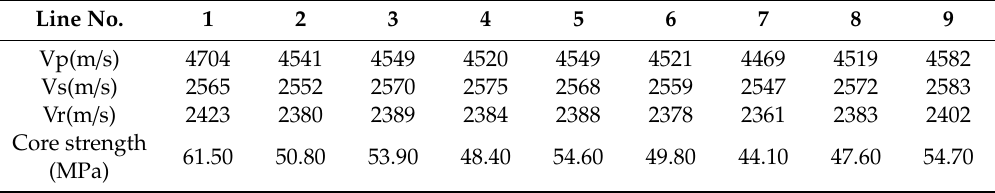
Table 7. Line-average P-, S-, and R-wave velocities and test strengths in S50D210 slab. Line